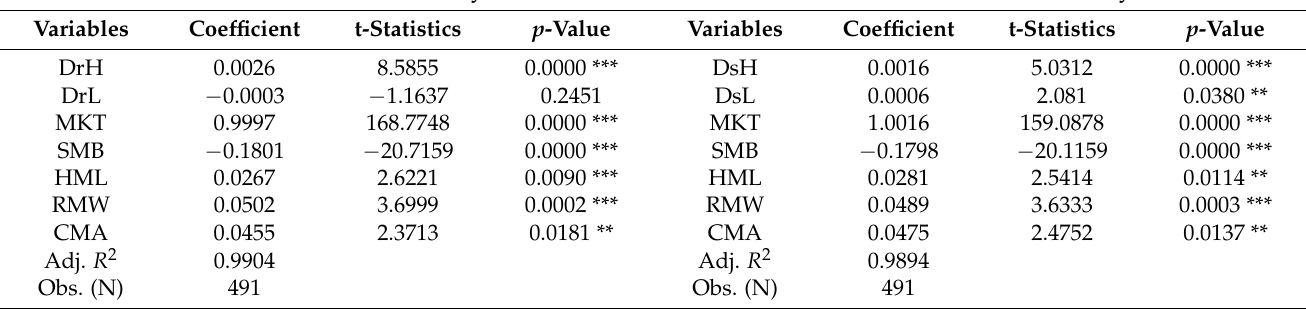
Table 8. Nominal interest rate cycles and consumer sentiment cycles on stock returns. Panel A presents the five-factor adjusted returns of the S&P 500 in interest rate cycles, Panel B presents the five-factor adjusted returns of the S&P 500 in sentiment cycles. The median of the long-term nominal interest rate is 5.81%, greater than (less than) the median defined as a high-interest rate (low-interest rate) cycle. The median of consumer sentiment is 89.6, greater than (less than) the median defined as a high-sentiment (low-sentiment) cycle. If dummy variable DrH equals 1, it indicates a high-interest rate cycle, and 0 otherwise; if DrL equals 1, it indicates a low-interest rate cycle, and 0 otherwise. If dummy variable DsH equals 1, it indicates a high-sentiment cycle, and 0 otherwise; if DsL equals 1, it indicates a low-sentiment cycle, and 0 otherwise. All t-statistics are based on the Heteroskedasticity- Autocorrelation-Consistent standard errors. **, and *** denote significance at the 5%, and 1% levels,